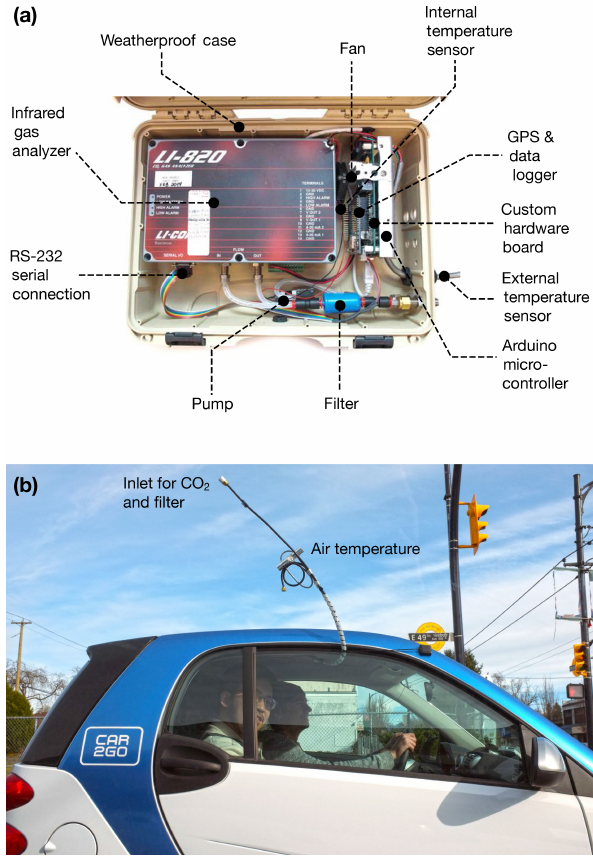
Figure 1. (a) Photo of the “DIYSCO 2 ” system (case open) with components labelled. (b) The inlet is mounted through the passen- ger window (right side) of the vehicle; the “DIYSCO 2 ” sits in the trunk